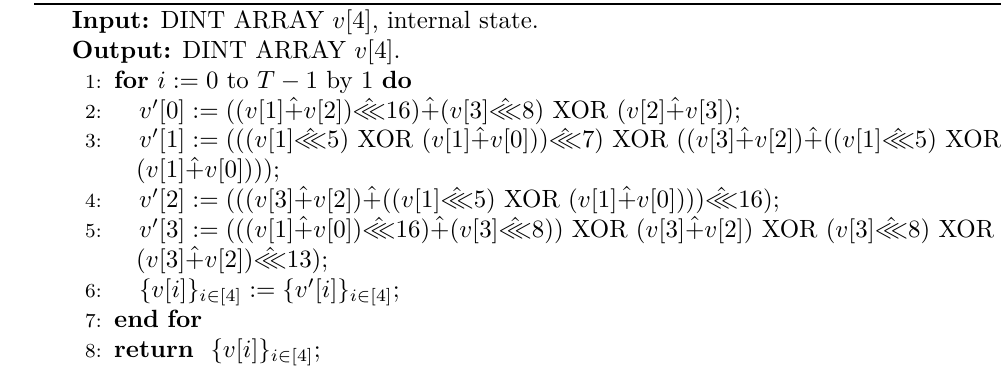
Algorithm 5: Permutation π c of